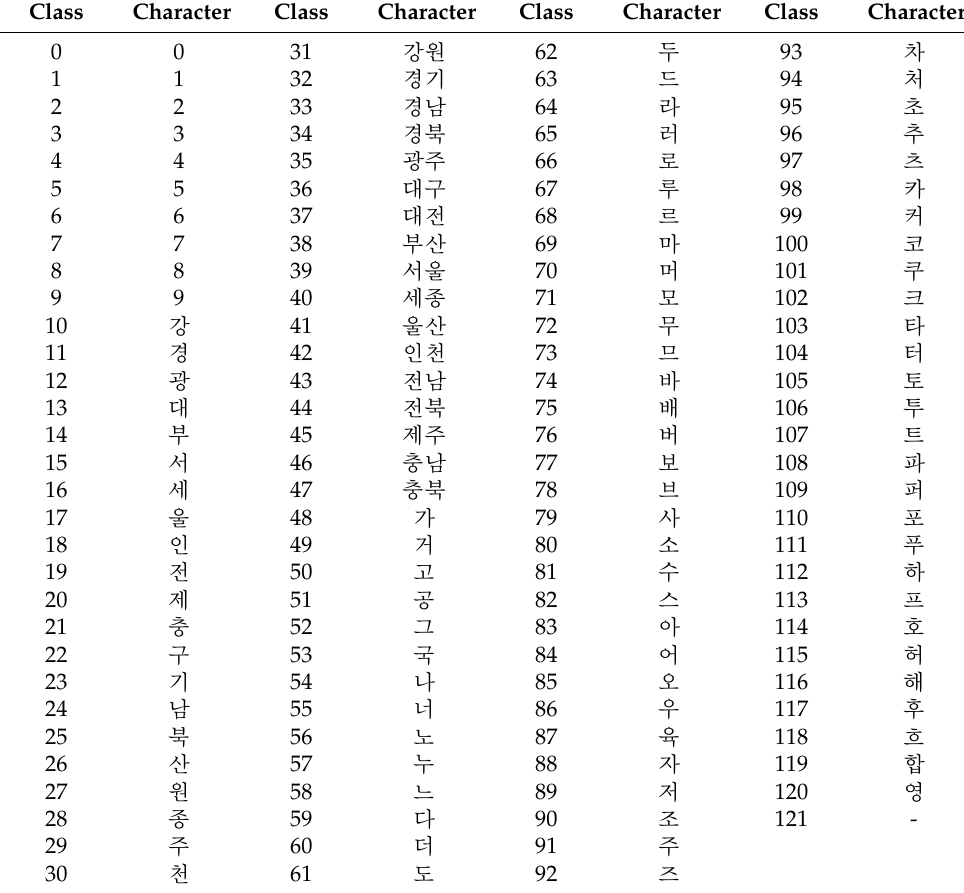
Table 2. 122 classes for character